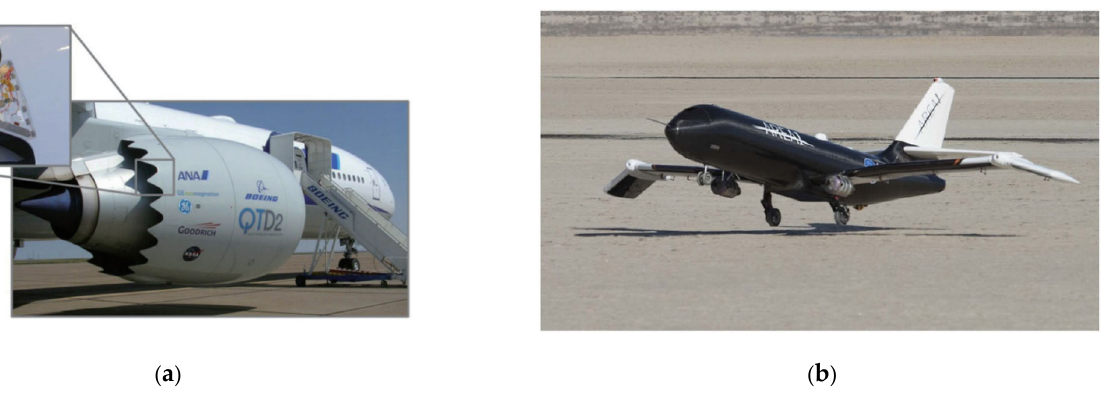
Figure 5. Examples of SMA materials in the aviation industry: ( a ) SMA-based shape control at Boeing 777-300ER airplane engines [78]; ( b ) SMA torque tubes are mounted in the chord-wise direction along the hinge ‐ line to control the articulation of the outboard wing section.